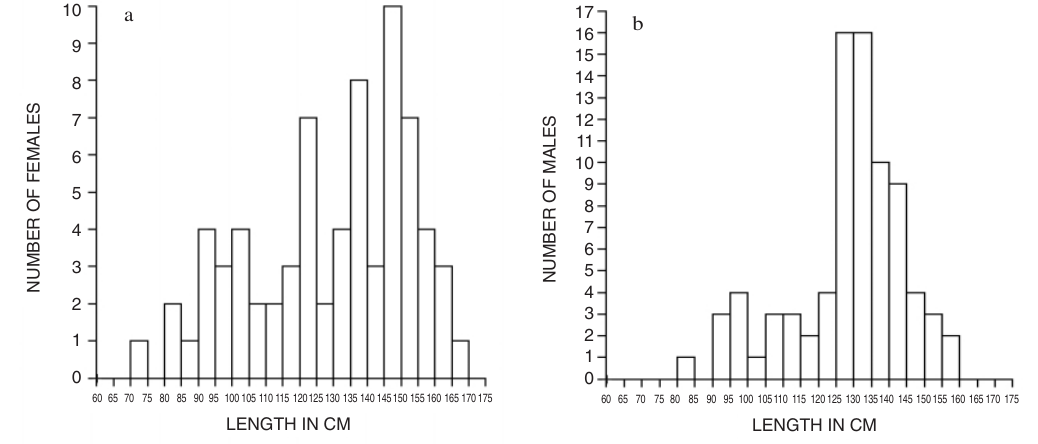
Fig. 4. Length frequency distributions for a) female porpoises, and b) male porpoises, from 3 regions of West Greenland (1988, 1989 and 1995) .